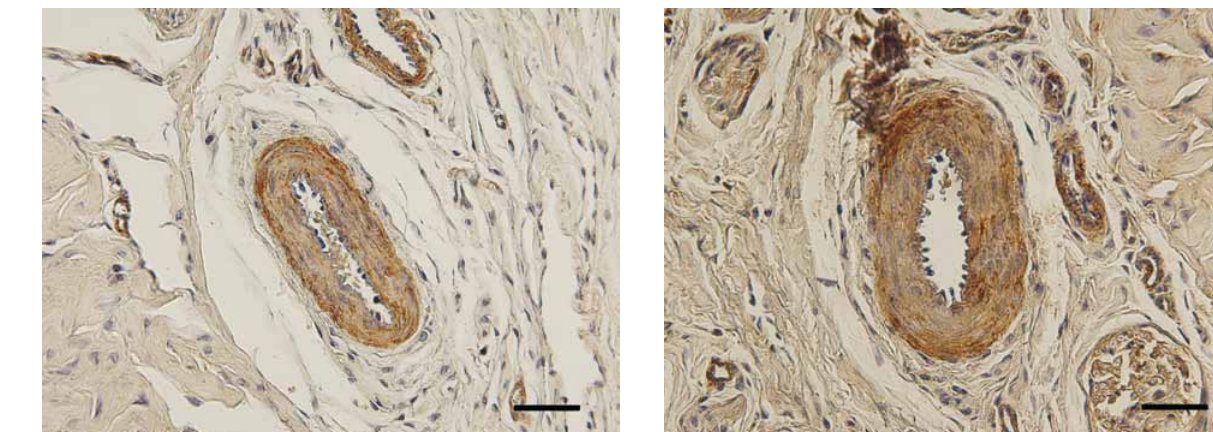
Figure 4 - Immunostaining of the smooth muscle in the tunica media of the DAP of rabbits from the diabetic group. Sections were stained with the anti-alpha-actin antibody, and images were taken at 400x magnification. Scale bar: